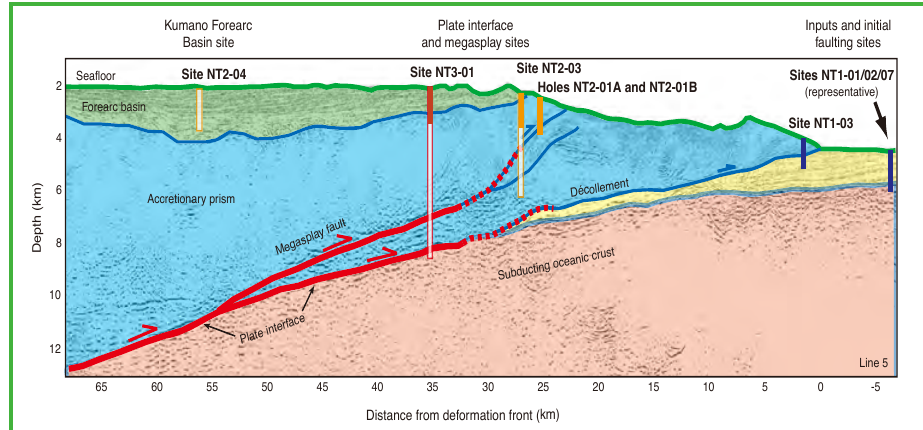
Figure 2. Prestack depth-migrated seismic line 5 of Park et al. (2002), with locations of planned drill sites. Riserless sites planned for Stage 1 drilling are shown in solid color, and riser-drilling sites are shown in outline. Faults labeled with red arrows are inferred possible co-seismic slip zones during 1944 event on basal decollement and mega-splay fault. Vertical exaggeration =